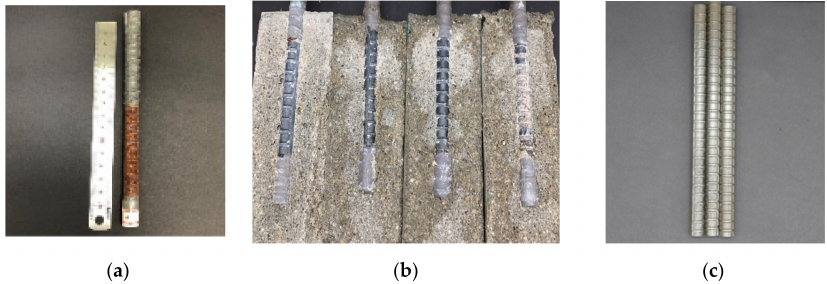
Figure 8. ( a ) Surface of pre-rusted rebar, ( b ) typical image of split mortar specimen, and ( c ) cleaned rebar.